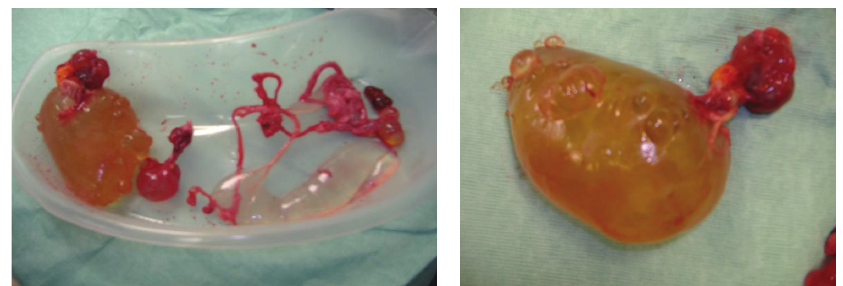
Figure 2: Excised multiloculated cyst with translucent fluid and peritoneal